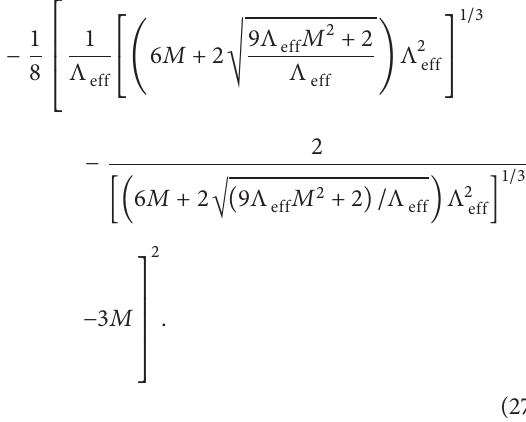
Figure 1: 𝐴(𝑟) as function of 𝑟 for different values of Λ and 𝛽 . The intersections with the 𝑟 -axis give inner and outer horizons. In (a), we set Λ = 0 , and (b) has Λ > 0 . In both cases, values of 𝛽 ≤ 0 give one horizon, while 𝛽 > 0 give two horizons or an extremal configuration (𝛽 = 𝛽 resembling the behaviour of Reissner-Nordstr¨om solution. Above this extremal value, there is no black hole. In (c), we consider the Λ < 0 case, and the behaviour shows no black hole